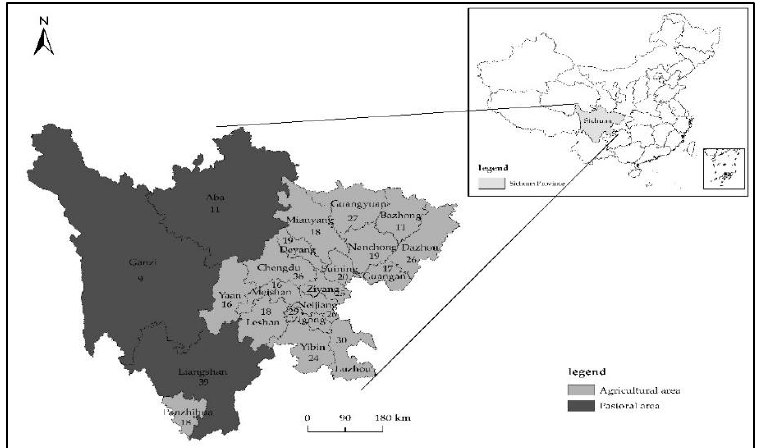
Figure 1. Study area and sample distribution. Note: The numbers in the figure, such as “Chengdu 36”, represent 36 sample data from Chengdu. Source: painted by Fanghua Li and it does not involve copyright